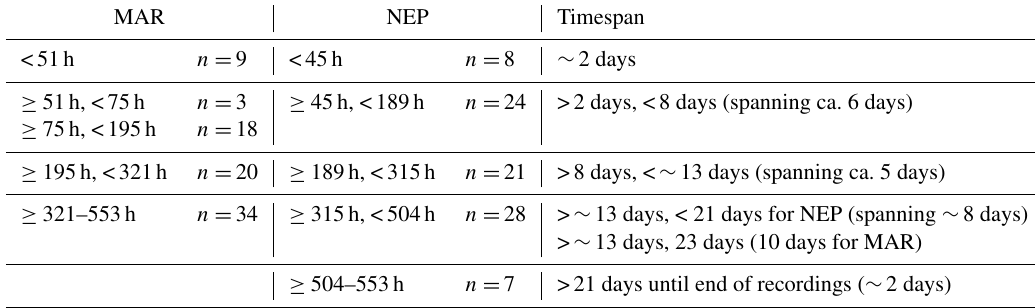
Table 3. Temporal split groups for MAR and NEP based on MRT analysis. n is the number of